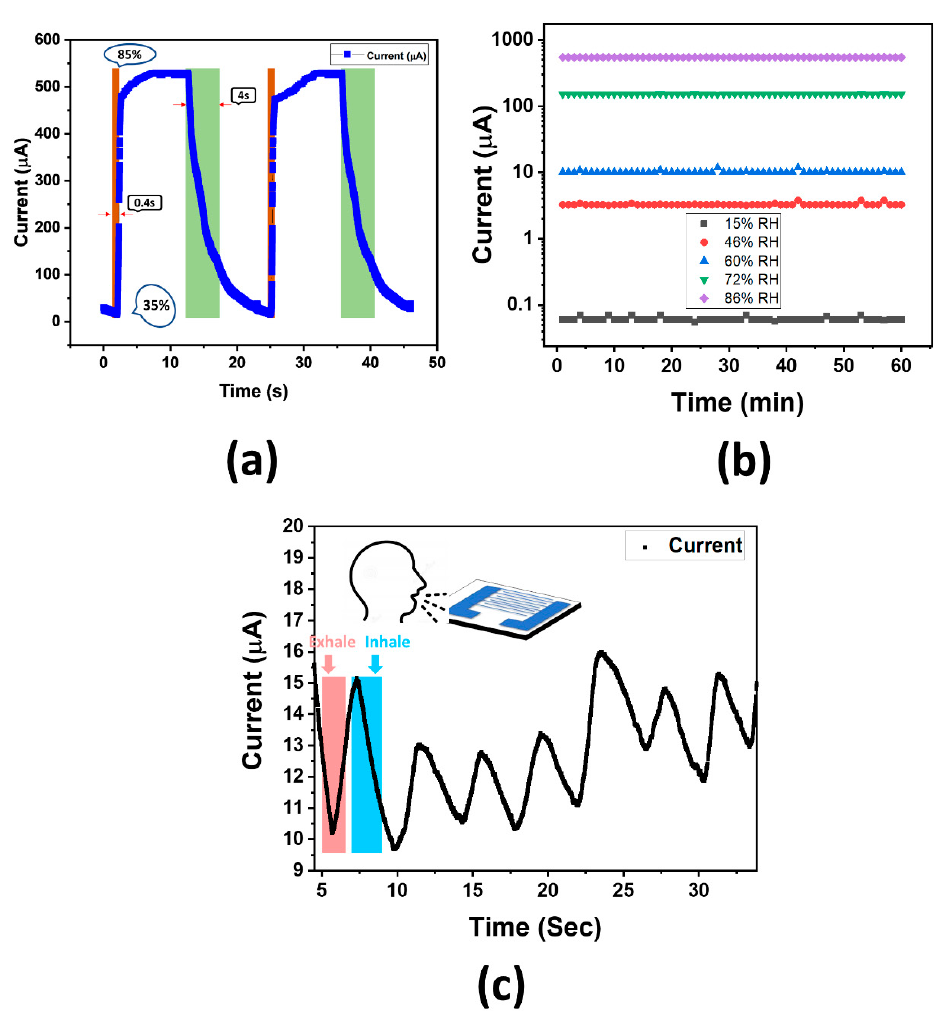
Figure 9. ( a ) Response and recovery time; ( b ) stability test of the proposed sensor, ( c ) sensor response to normal human breathing.